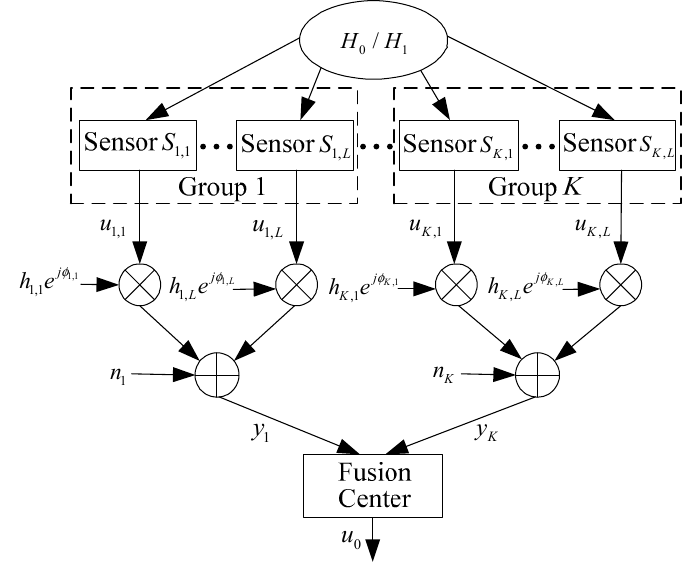
Figure 1. System Figure 1. System model.